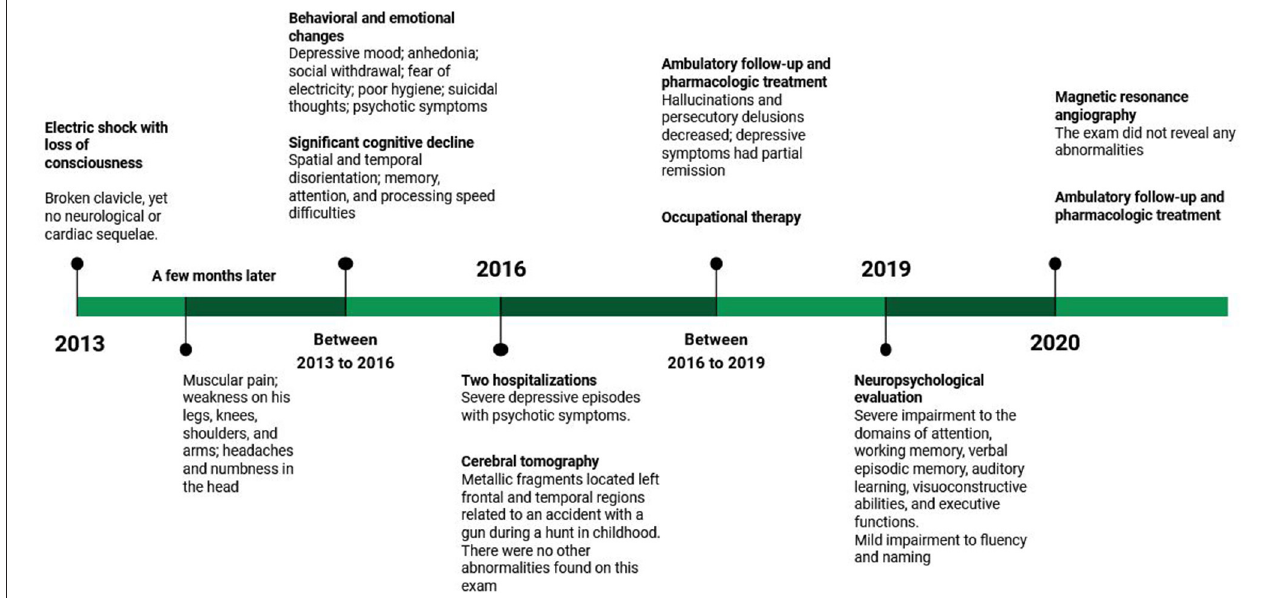
FIGURE 1 | Timeline with relevant data from care.